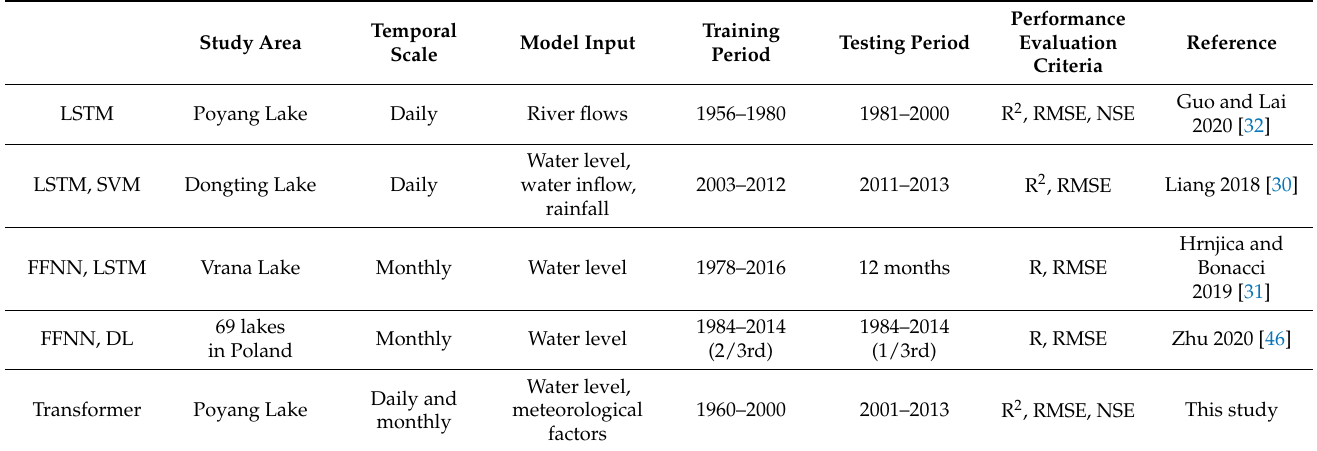
Table 3. Studies applying deep learning models for water level prediction in lakes.